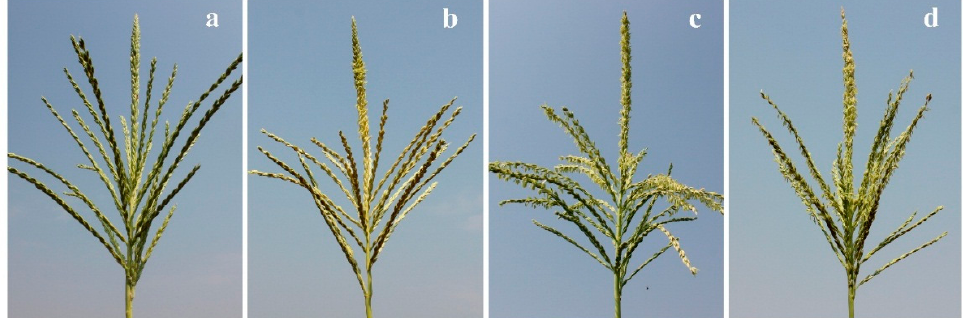
Figure 2. Four stages of corn tassel development: VT tassel ( a ), 1st day of pollen shed ( b ), 50% of pollen shed ( c ), and 75% of pollen shed ( d ).